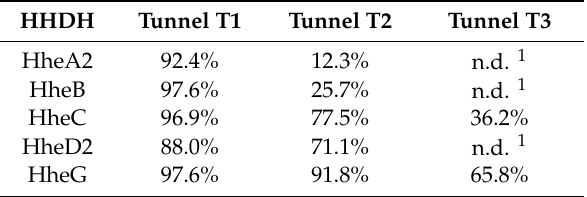
Table 2. Computed tunnel frequency for each HHDH subclass (see